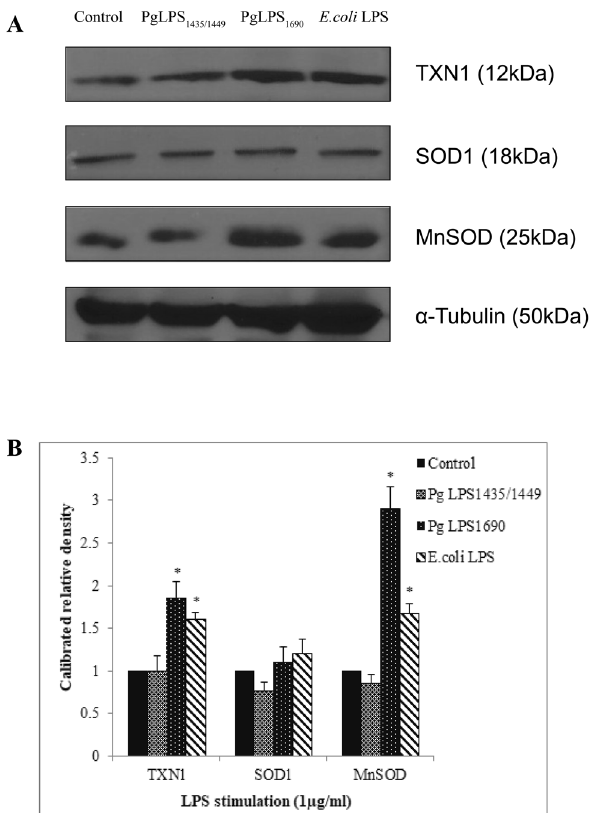
Figure 2. A correct version of the original Figure